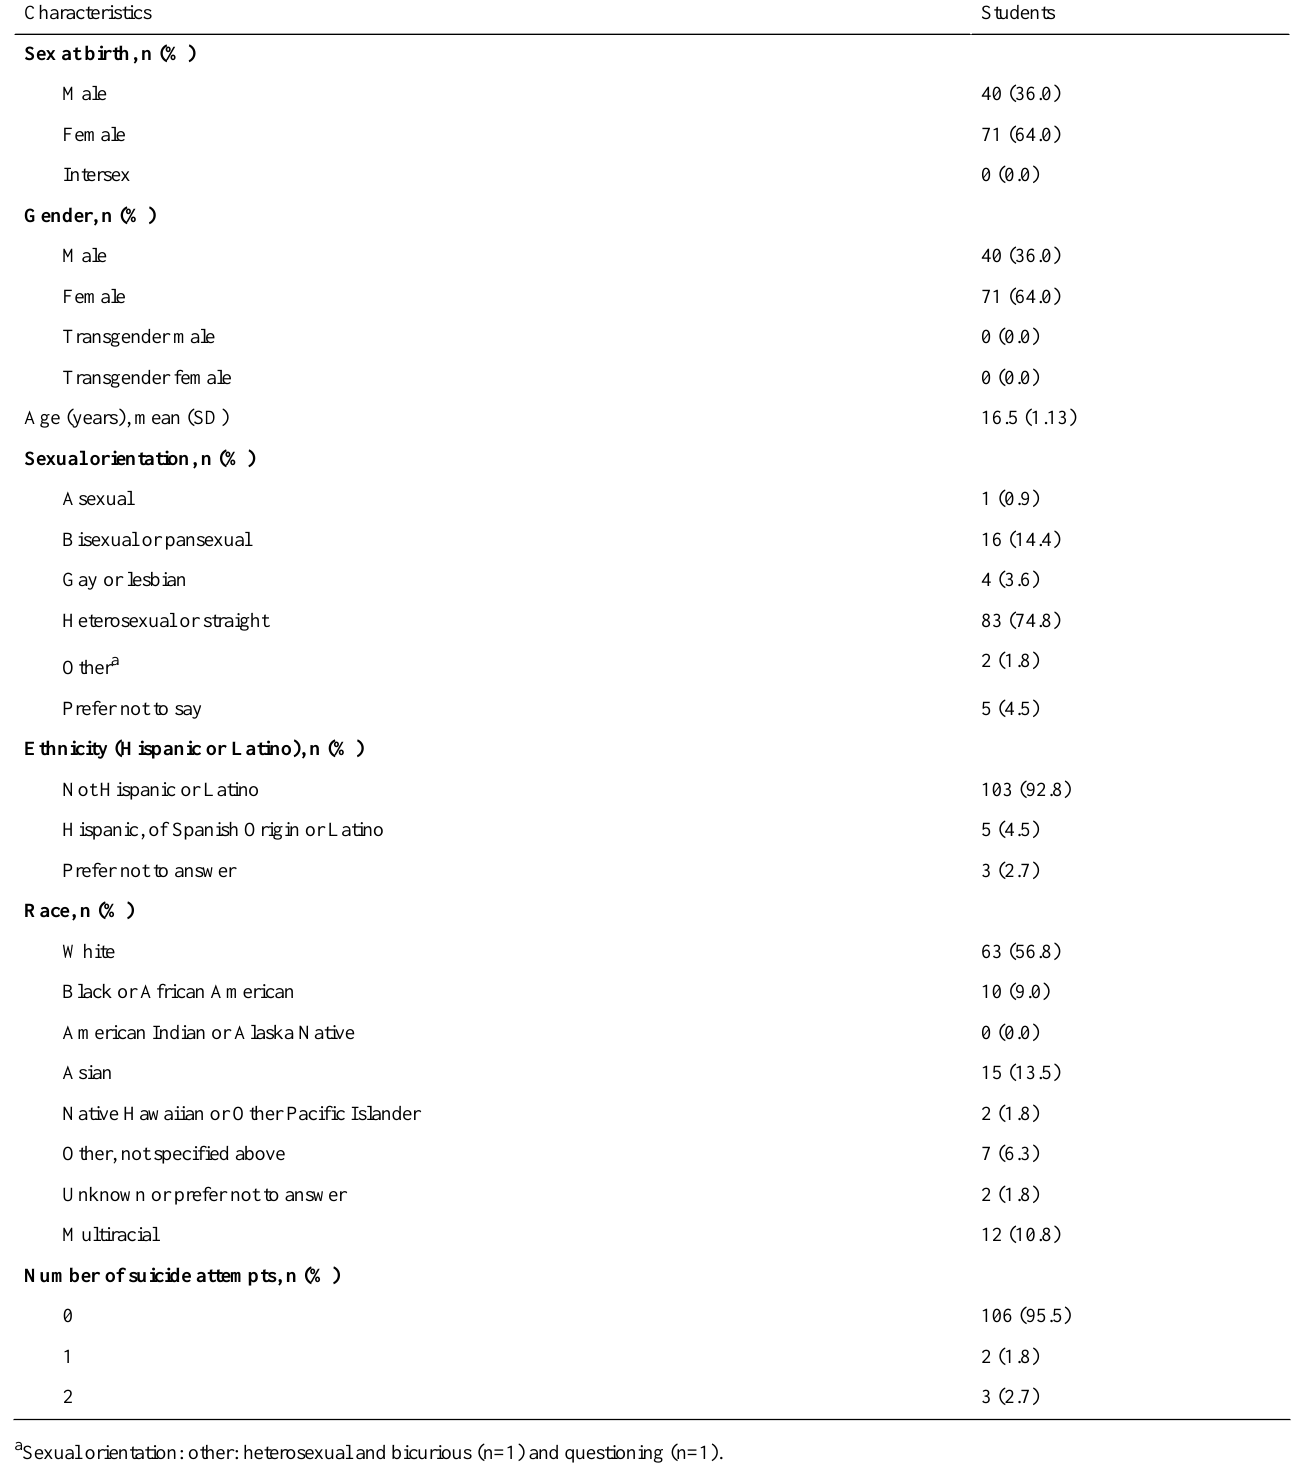
Table 2. Summary of demographics and clinical characteristics for student participants